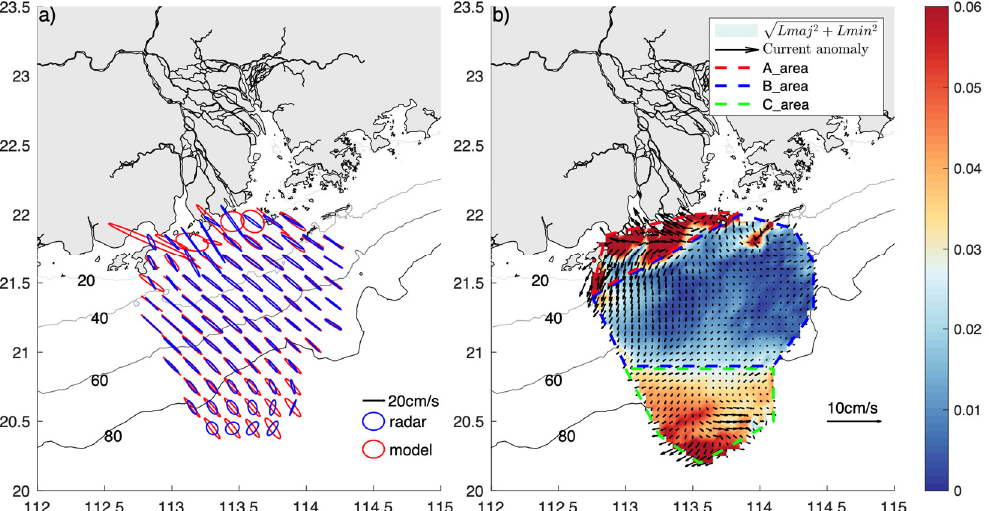
Figure 7. ( a ) M 2 tidal ellipses for HF radar (blue line) and model (red line) in the radar coverage area. The data are plotted at 0.05° intervals. ( b ) Error distribution of the M 2 ellipse amplitude (cm/s, shaded) and current anomaly (cm/s, vector). Isobaths (m) are marked with color-changing solid lines. The current anomaly was derived as V radar − V model .